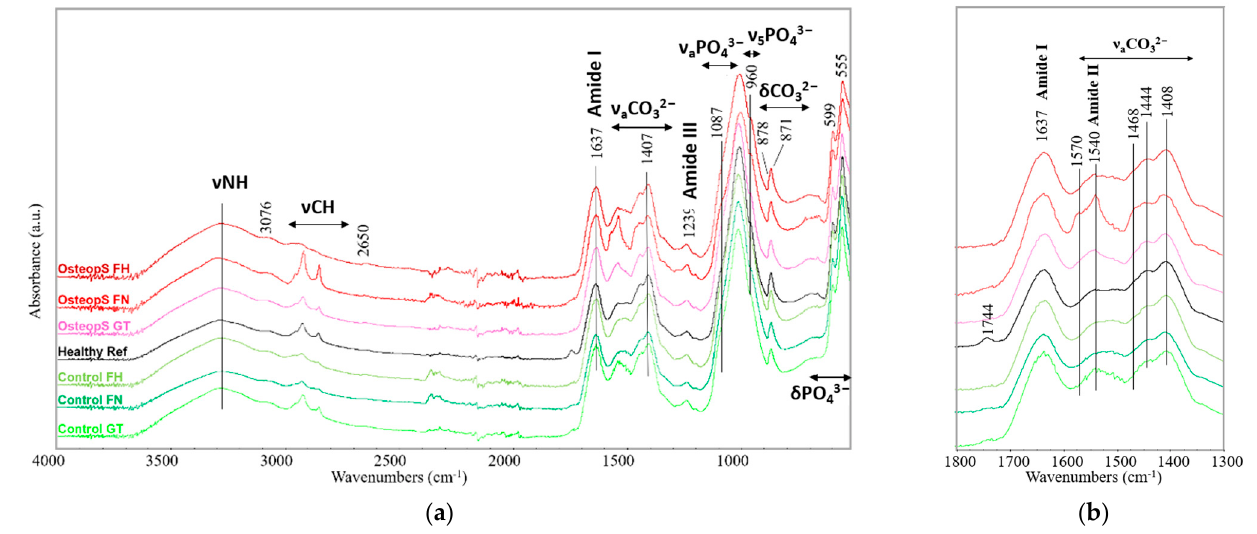
Figure 7. ( a ) ATR-FTIR spectra of the whole set of subjects and subregions. “OsteopS” refers to osteoporotic sample (S08); “Healthy Ref” refers to a refence sample of a healthy 61-year-old male; “FH” refers to femoral head, “FN” refers to femoral neck; “GT” refers to great trochanter. ( b ) Focus in the Amide I, Amide II and carbonate region (1300-1800 cm − 1